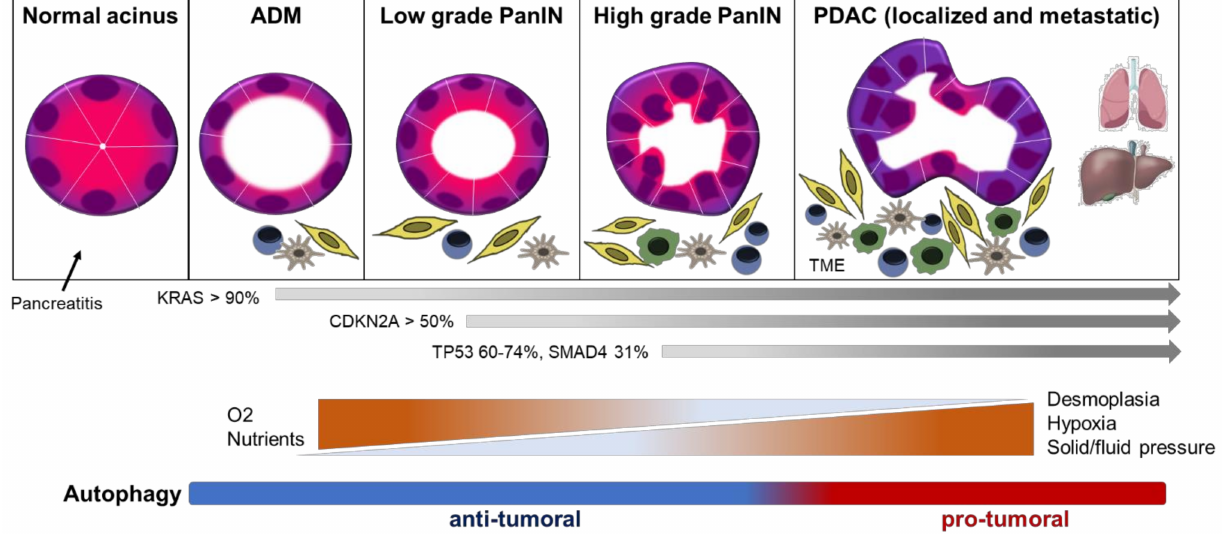
Figure 1. Schematic representation of Pancreatic Ductal Adenocarcinoma (PDAC) carcinogenesis, the main genetic events involved, and key metabolic features. PDAC is a malignant epithelial neo- plasm that arises from the exocrine portion of the pancreas, mainly from the acinar cells. Under severe stress conditions such as pancreatitis, acini can transform into duct-like structures, termed acinar–ductal metaplasia (ADM). ADM frequently progress to the well-characterized pancreatic intraepithelial neoplasias (PanINs), defined as mucinous-papillary proliferations with a ductal ap- pearance. These lesions can be classified into low or high grade PanINs based on the degree of architectural and nuclear atypia. Genomic mutations of pancreatic cancer predominate in four genes, the KRAS oncogene and the tumor suppressor genes CDKN2A , TP53 , and SMAD4 . KRAS oncogenic mutations are nearly ubiquitous in PDAC and occur early in carcinogenesis, and more importantly, these point mutations drive constitutive KRAS activation thus maintaining cell proliferation and survival. Subsequent mutations in the tumor suppressor genes are present later further contributing to disease progression. Besides genetic alterations, PDAC is characterized by a prominent fibrotic stroma (desmoplasia), consisting of abundant extracellular matrix (ECM) and stromal cells in the tumor microenvironment (TME). This TME is very heterogeneous in terms of the variety of stro- mal cell subtypes, which includes cancer-associated fibroblasts (CAFs, in yellow), immune cells such as lymphocytes (blue) and macrophages (green), stroma-associated pancreatic stellate cells (PSCs, in gray), among others. This prominent TME exerts high levels of solid and fluid pressure, and compression of vasculature, limiting oxygen and nutrient availability during PDAC progression. Notwithstanding, pancreatic cancer cells are well adapted to these adverse conditions by several mechanisms, including autophagy, which shows both pro- and anti-tumorigenic effects depending on the context. In PDAC, autophagy can prevent cancer initiation at early steps of the disease, and in established tumors, autophagy supports PDAC growing and maintenance by different